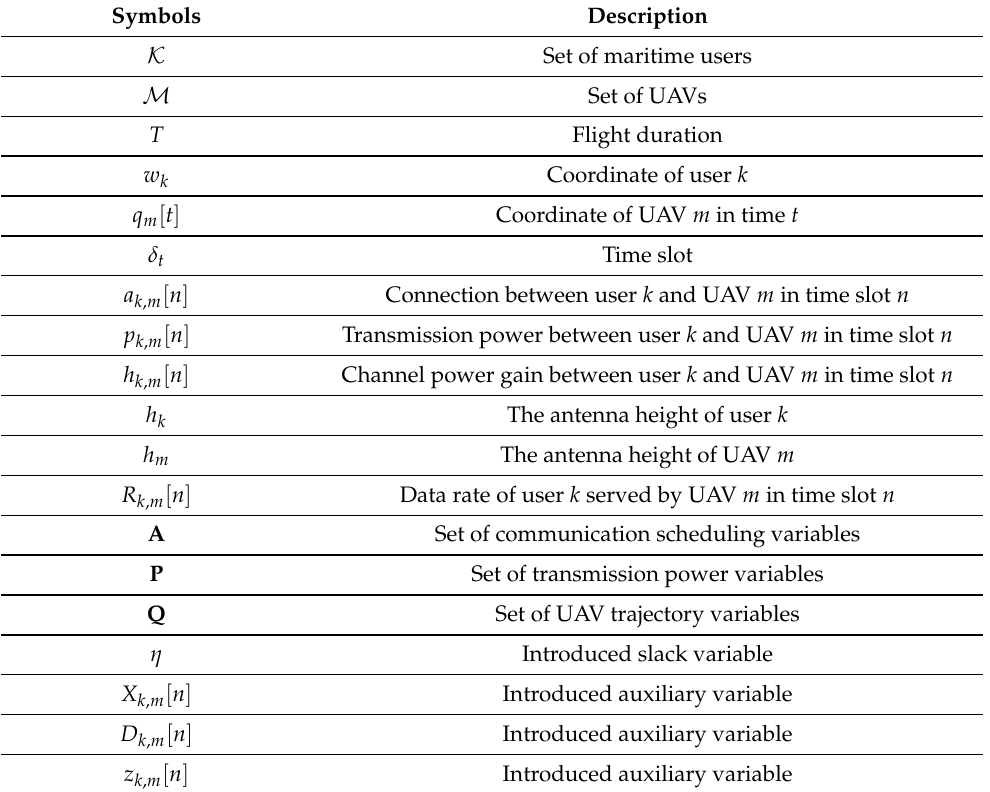
Table 1. Notations.